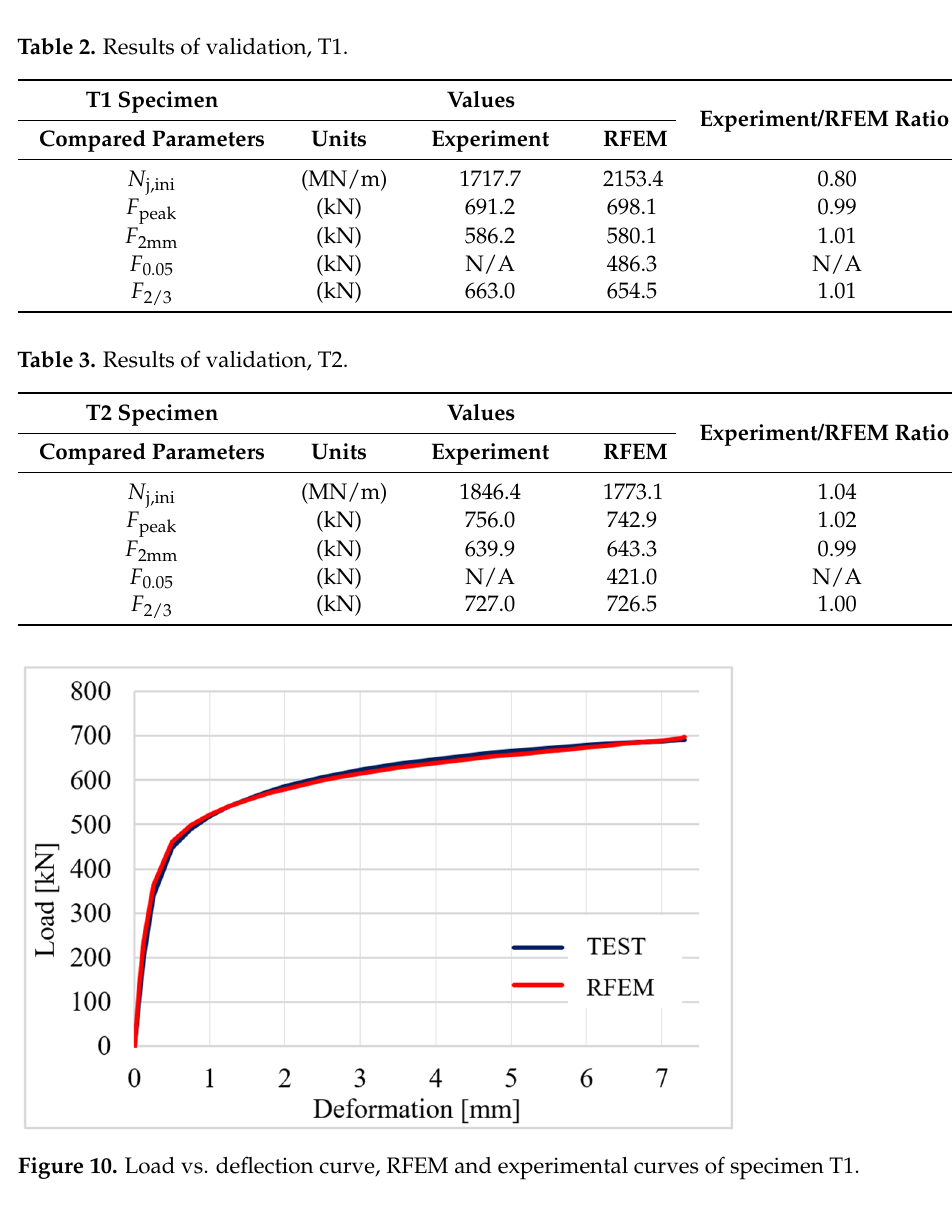
Figure 11. Load vs. deflection curve, RFEM and experimental curves of specimen T2. Despite some differences between numerical simulation and physical tests, there is a good rate of compliance in tested parameters. The maximal difference between the com- pared values is 20% in the case of initial stiffness of the T1 model (see Table 2). For initial stiffness, the higher rate of difference is acceptable because the value is dependent on many factors, for example, the mesh size around the bolt holes or the initial contact area influencing the bearing of bolts in experimental tests. However, besides this one value, the other compared parameters vary from 0–4% so the models can be used for the verifi- cation of design-oriented models. Additionally, it is worth noting that in a deformed numerical model, signs typical of block shear failure mechanisms could be observed, such as necking on a tension plane and yielding on the outer plane of bolt holes (see Figure 12).